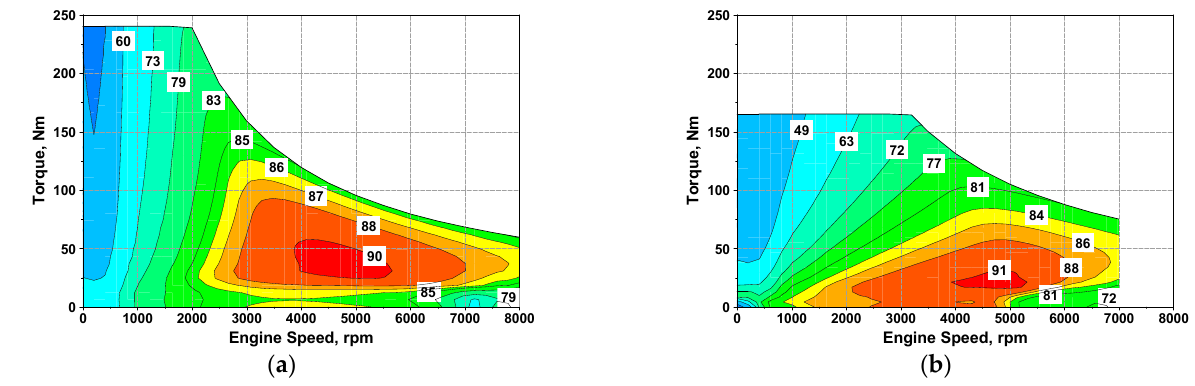
Figure 3. Efficiency maps (-) of electric motor (EM) ( a ) and electric generator (EG) ( b ). Aiming at testing the robustness of the proposed control strategy, as said, some analyses are performed with a more conventional turbocharged downsized stoichiometric engine, labeled as engine 2 [24], whose BSFC map is shown in Figure 4.